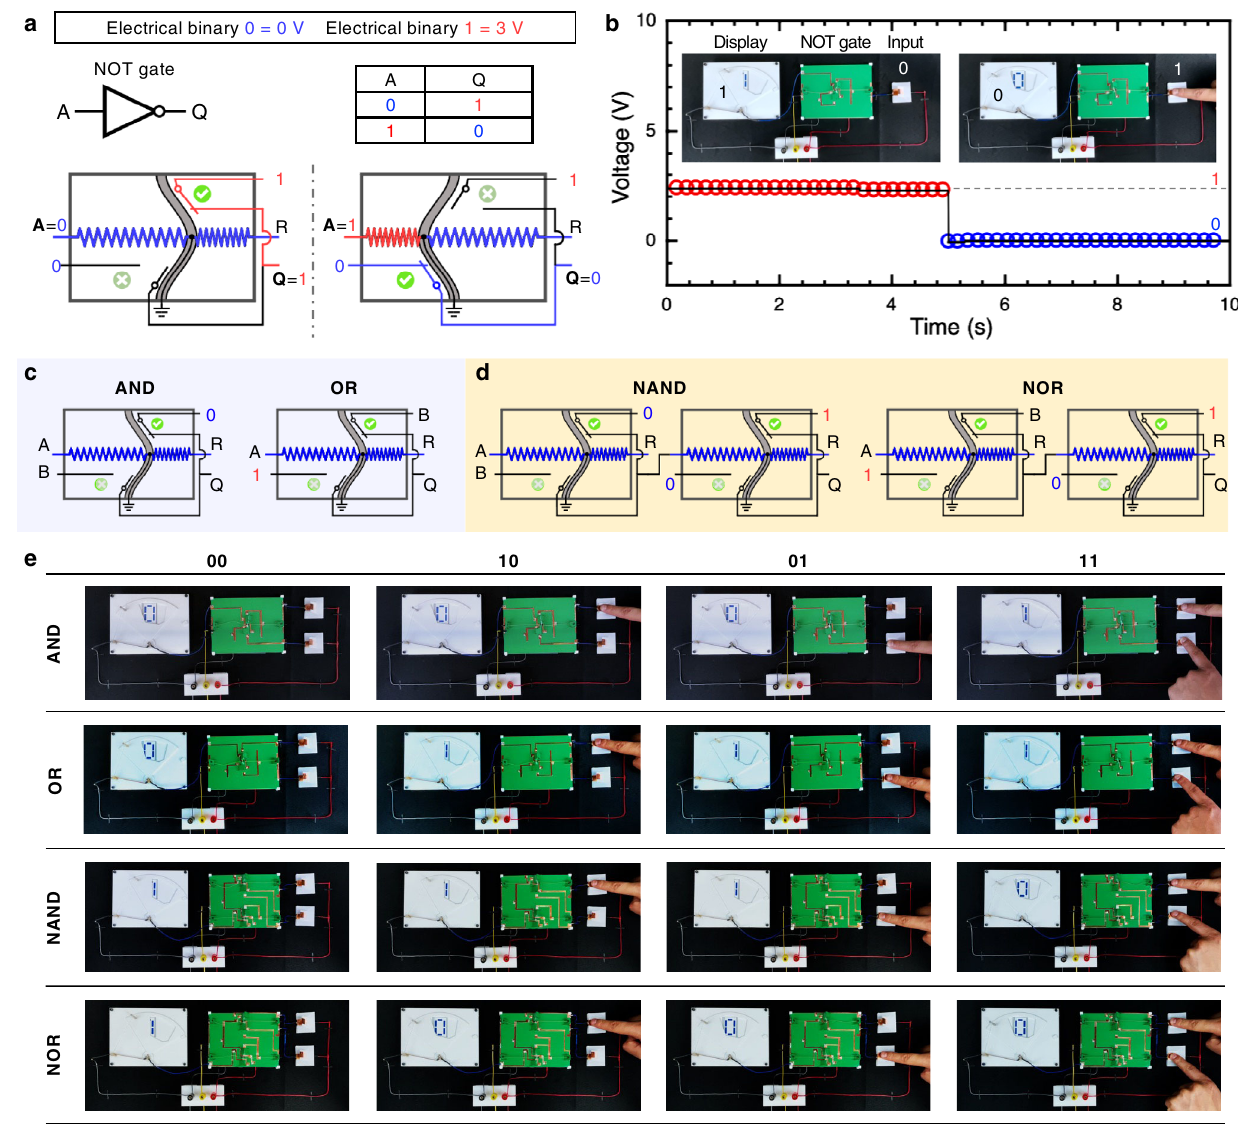
Fig. 3 | OMS-based digital logic gates. a Anorigami NOT gate. Logic diagram and truthtableofaNOTgate.TheschematicofanorigamiNOTgateinourarchitecture. b TheinputoftheNOTgateissuppliedbyanorigamiswitch;theoutputoftheNOT gate is used to drive a CSCP actuator to change the reading ( ‘ 0 ’ or ‘ 1 ’ ) of a display. c Bycon fi guring OMS,the other twofundamentallogicelements, i.e., AND and